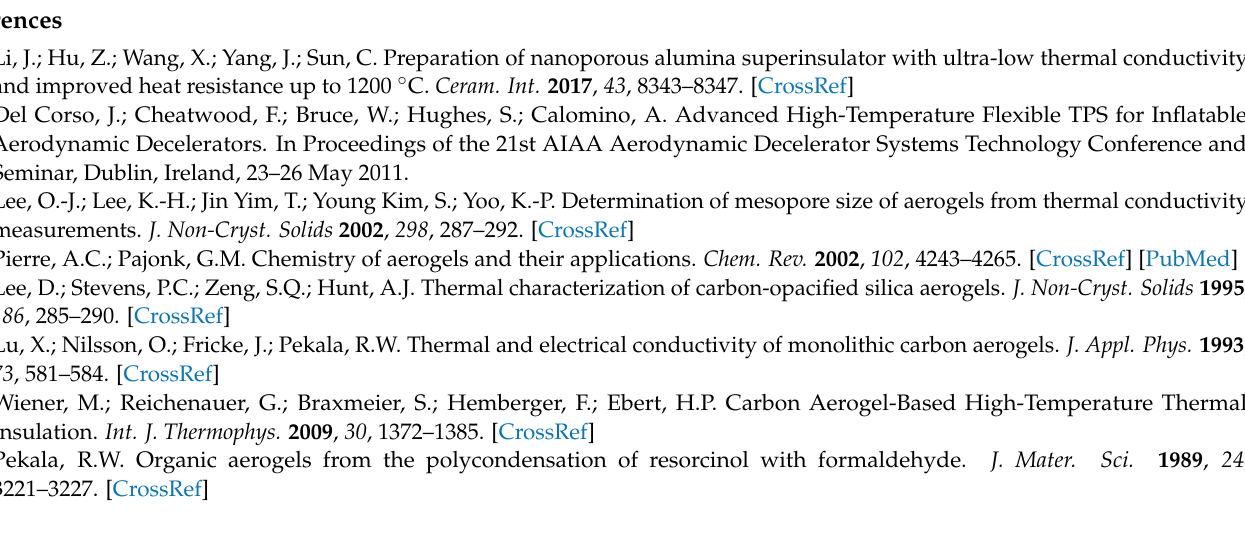
Table S1. The density of polyimide aerogels, pre-carbonized foams and composite samples before and after carbonization. Table S2. Textual properties of phenolic resin-based carbon previous research. Table S3. Specific heat and thermal diffusion coefficient of CF-CPI and CF at different